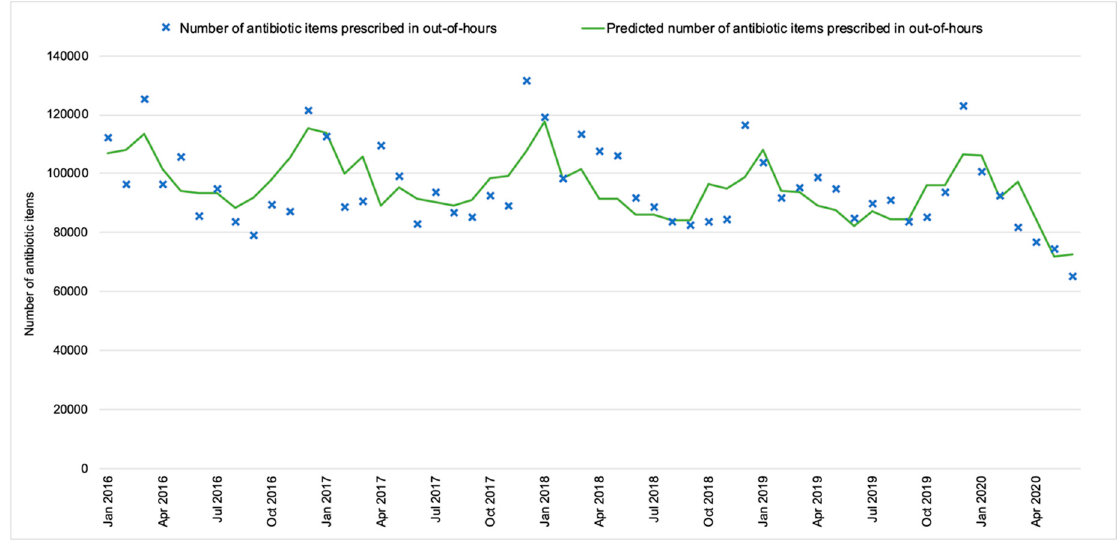
Figure 4. Urinary tract infection antibiotic items prescribed in out-of-hours (England, 2016–2020). 2.4. Out-of-hours Antibiotic Prescribing in the Context of the COVID-19 Pandemic The trend of the OOH antibiotic prescribing volume between January 2016 and Feb- ruary 2020 remained stable. Since March 2020, there has been a decrease of 5088 items per month (95% CI: -6264.4 to -3912.0). The predicted monthly OOH antibiotic prescribing volume is presented in Figure 5 to illustrate the variation from the historical trend that would have been expected in the absence of the COVID-19 pandemic (Figure 5).